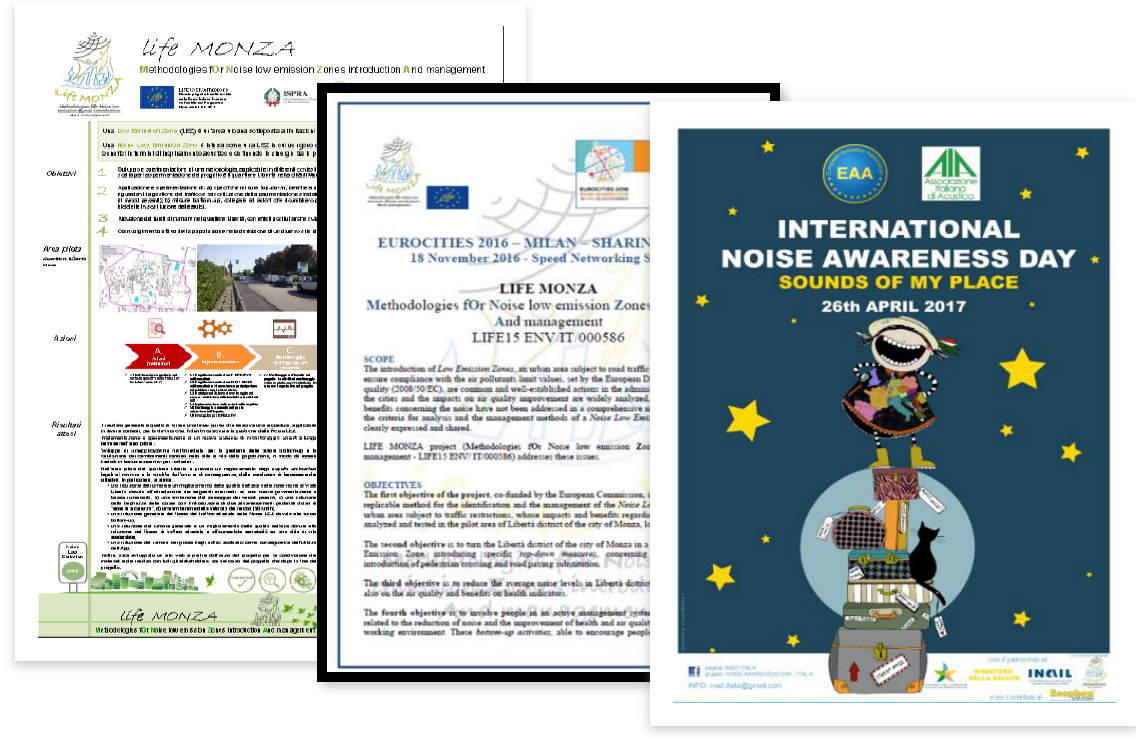
Figure 7: Documents presented during some dissemination